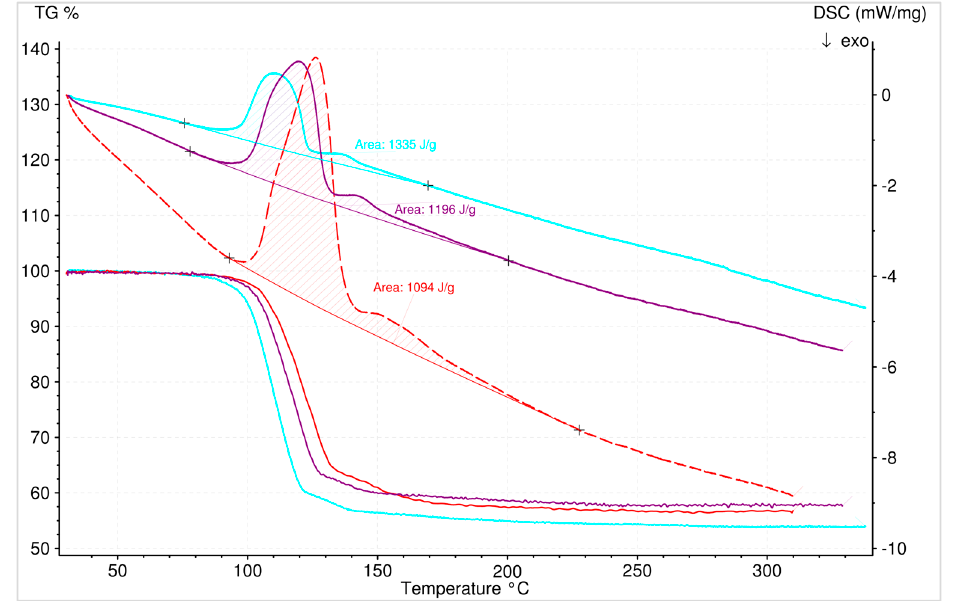
Figure 12. Dehydration (TG and DSC) of 2 mg H 3 BO 3 at different heating rates of 2 (turquoise), 4 (violet), and 8 °C/min (red) with the specific energy content of the reaction (1.3, 1.2, and 1.1 KJ/g).